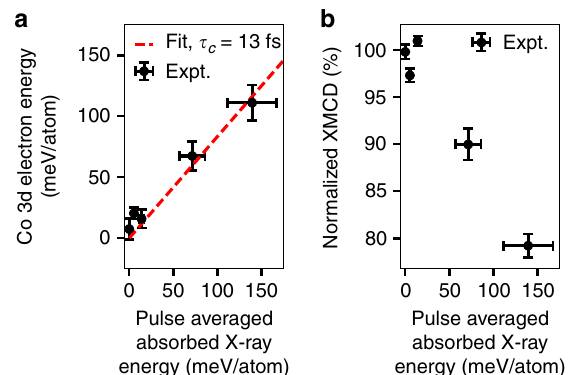
Fig. 4 Quanti fi cation of X-ray absorption changes. The quantities derived from the X-ray absorption changes are plotted as a function of the pulse averaged energy absorbed in the Co/Pd multilayer (one half of the total absorbed energy). Vertical error bars correspond to the standard error of the displayed quantities while horizontal error bars correspond to the estimated 20% uncertainty in the absolute fl uence calibration. a Co 3d electron energy averaged over the X-ray pulse as calculated from the fl uence-dependent XAS changes. The linear fi t to the data (dashed red line) has a slope of 0.83 indicating that 83% of the pulse averaged absorbed X- ray energy is stored by 3d states within 2 eV of the Fermi level (averaged over the pulse duration). Comparing this value to a simple model for the transfer of absorbed X-ray energy to electrons within 2 eV of the Fermi level, we estimate the duration of this cascade process to be τ b Normalized XMCD strength averaged over its FWHM extent in photon energy. Source data provided as a Source Data fi